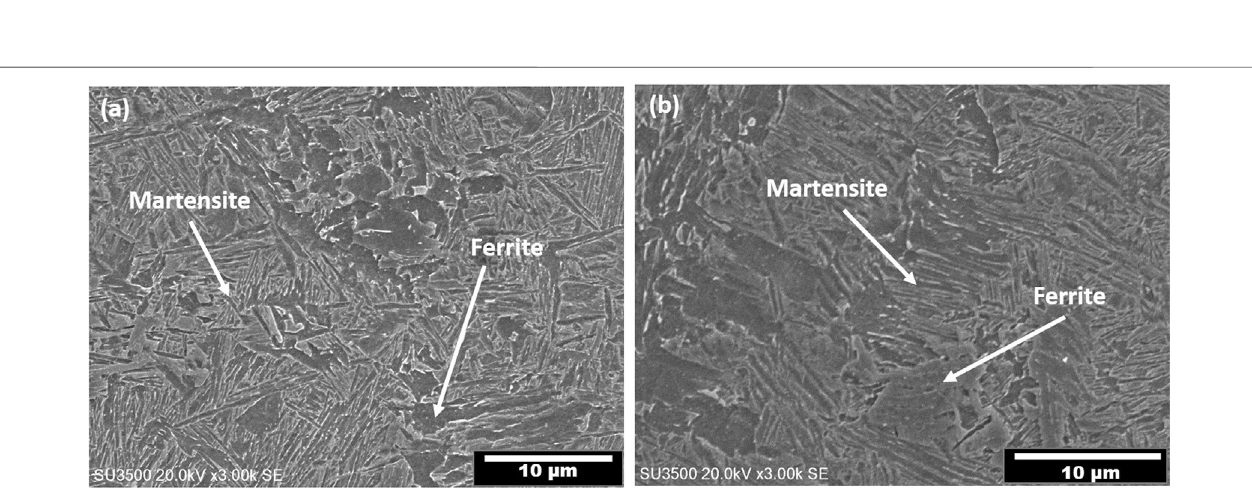
Frontiers in Materials |